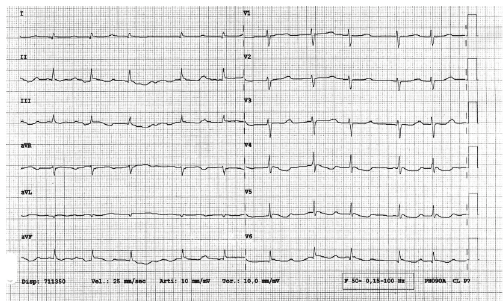
Figure 2: 12 leads EKG after prolonged